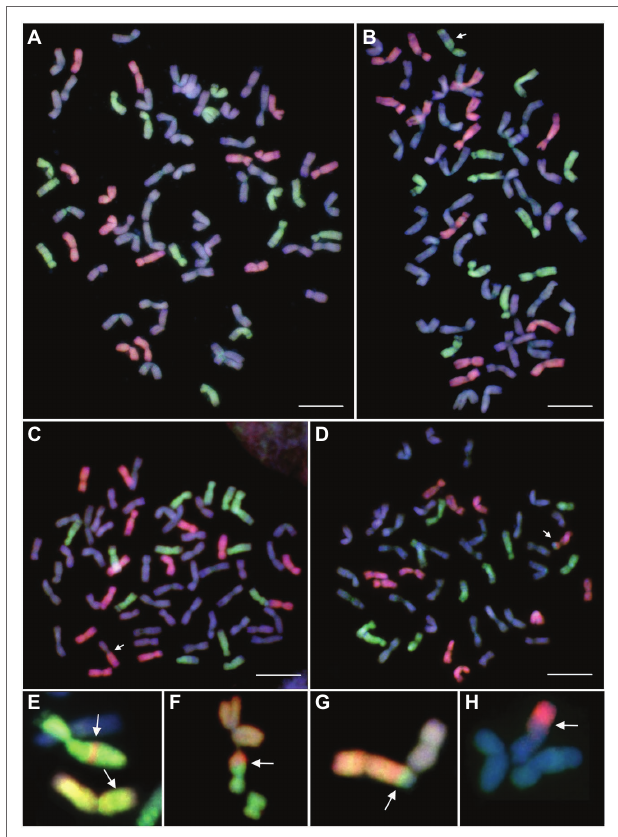
FIGURE 6 | Mitotic metaphase plates of Mv9kr1 ph1b_ K × Aegilops biuncialis amphiploid after GISH with differentially labeled M- and U-genomic probes allowing the discrimination of Ae. biuncialis M b —(red) and U b —genome (green) chromosomes from those of unlabeled wheat chromosomes (blue). Partial amphiploid cell without intergeneric recombinant chromosomes (A) , a partial cell of 201,226 amphiploid carrying an U b -wheat intercalary translocation (B) , a cell of genotype 201,246 carrying a wheat-M b Robertsonian translocation (C) , and a cell of genotype 201,216 carrying an M b -wheat terminal translocation (D) . Reciprocal intercalary (E) and terminal translocations (F-H) detected in additional amphiploids (201,225, 21,413, 201,245, and 21,407, respectively). The recombinant chromosomes are indicated by arrows. The chromosomes were counterstained with DAPI (blue). Scale bar = 10 μ